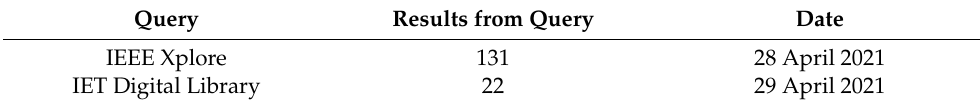
Table 2. Results of search queries in the